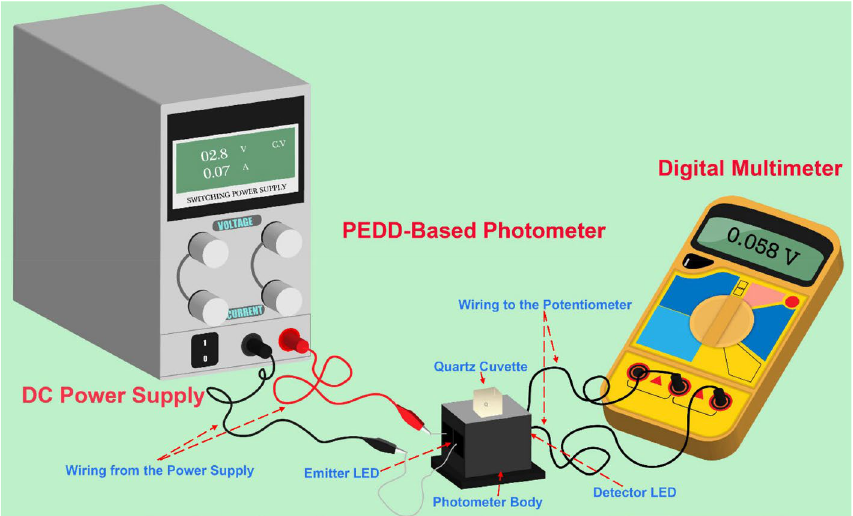
Figure 4. A schematic illustration of the developed PEDD-based photometric system for the determination of residual active chlorine in milk